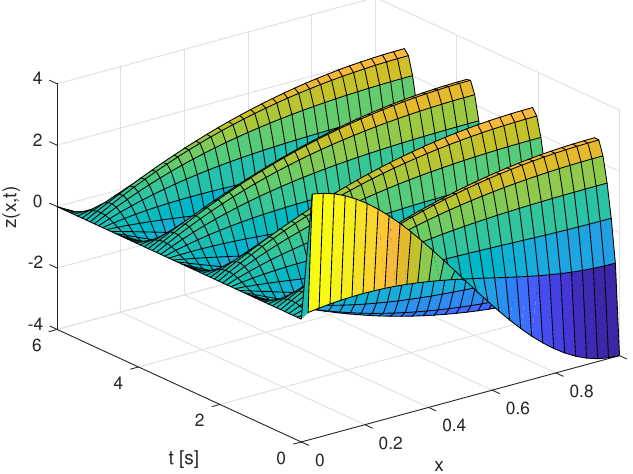
Figure 5. Solution surface for the case in which the reaction term is omitted, i.e., to the case for which λ = 0.